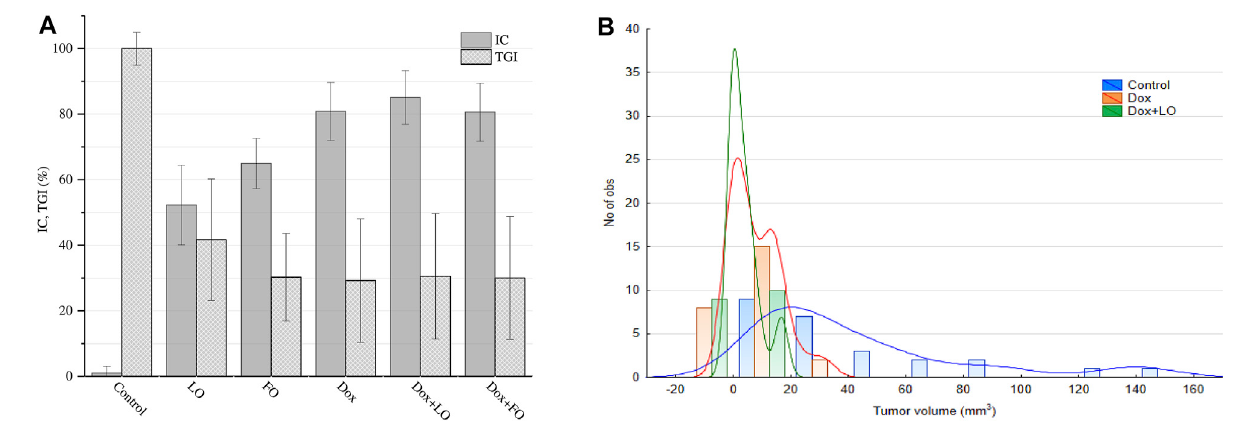
FIGURE5| LLC tumor growth inhibition coef fi cient (IC) values 12 days after thestartoftreatmentand tumor growth index (TGI) valuescorrespondingtothe whole treatment period (A) . The frequency distribution of tumor volumes 12 days after the start of treatment and the estimation of distribution density using Gaussian Kernel methods (B) . The values represent the mean % ± SE (A) . The data correspond to two independent experiments.